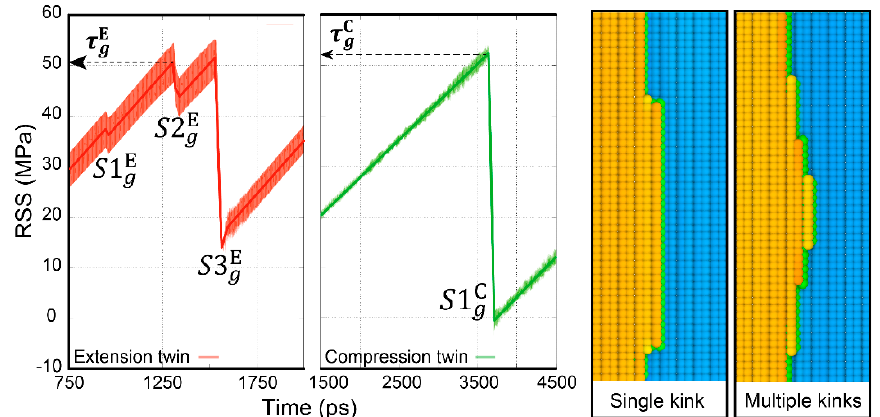
Figure 2. On the left is the stick-slip behaviors separately of two TDs reflected by the time dependencies of RSS. The measured RSS data are made translucent, and the solid lines are smoothed data after noise filtering. On the right are the captured kink pairs on a TD line.